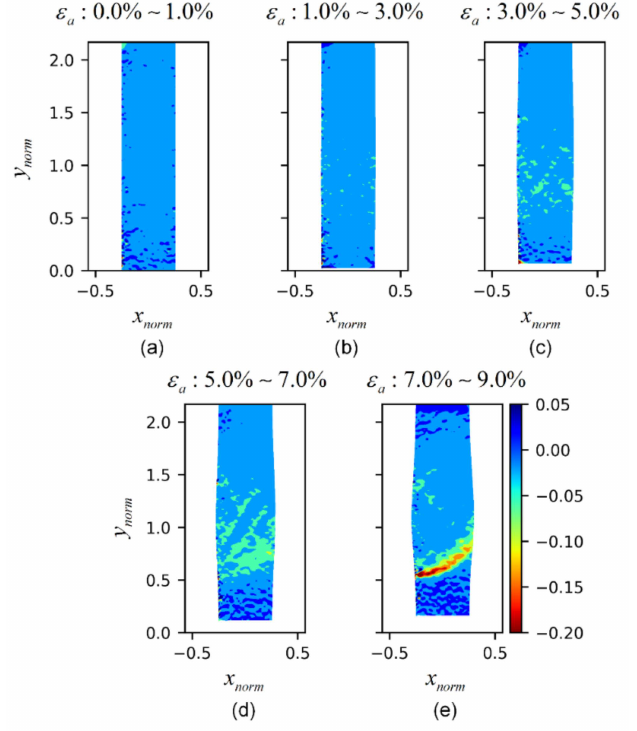
Figure 16. Evolution of gradient along ˆ y axis F 33 of test 121304d: ( a ) axial strain 0.0%–1.0%; ( b ) axial strain 1.0%–3.0%; ( c ) axial strain 3.0%–5.0%; ( d ) axial strain 5.0%–7.0%; ( e ) axial strain